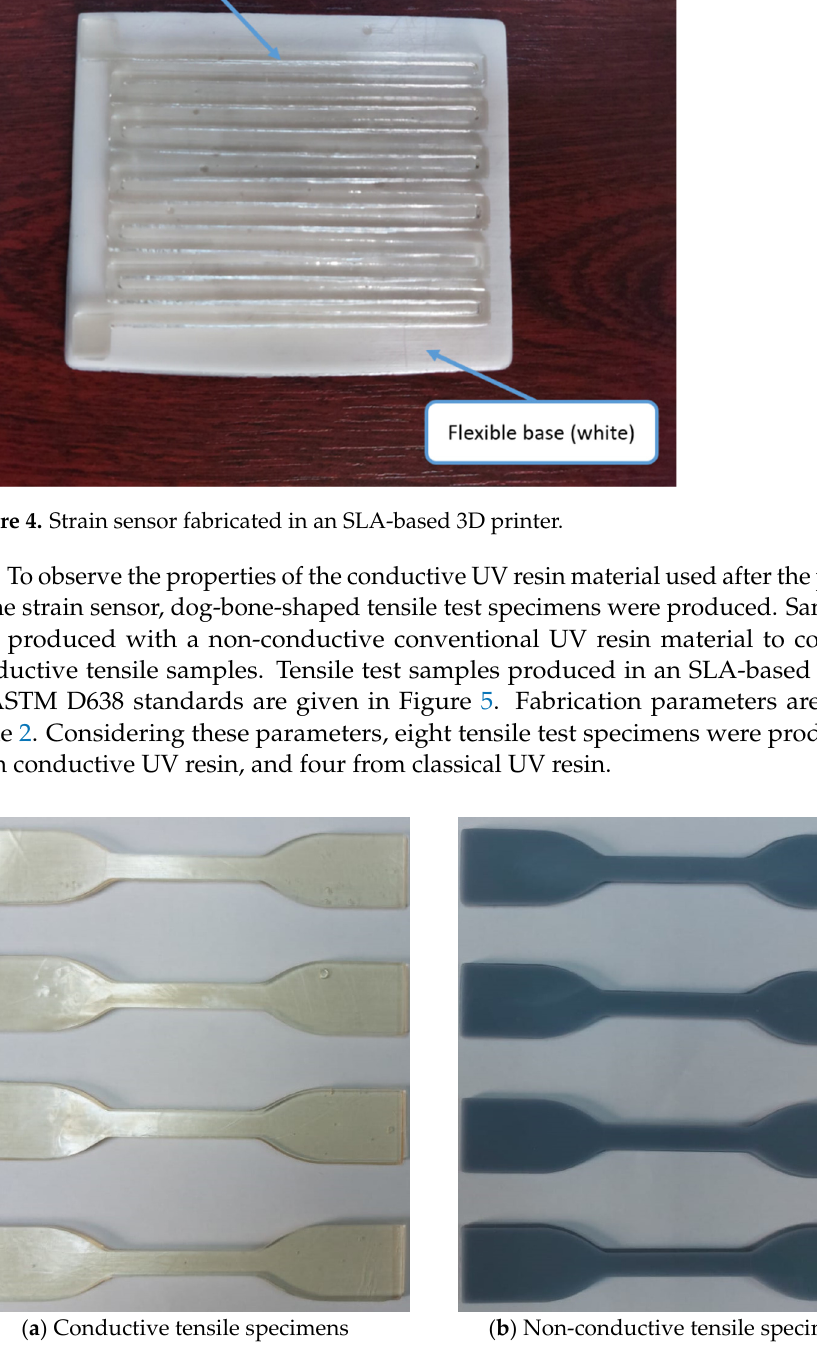
Figure 5. Conductive and non-conductive tensile test specimens fabricated with an SLA-based 3D printer in ASTM D638 standards.